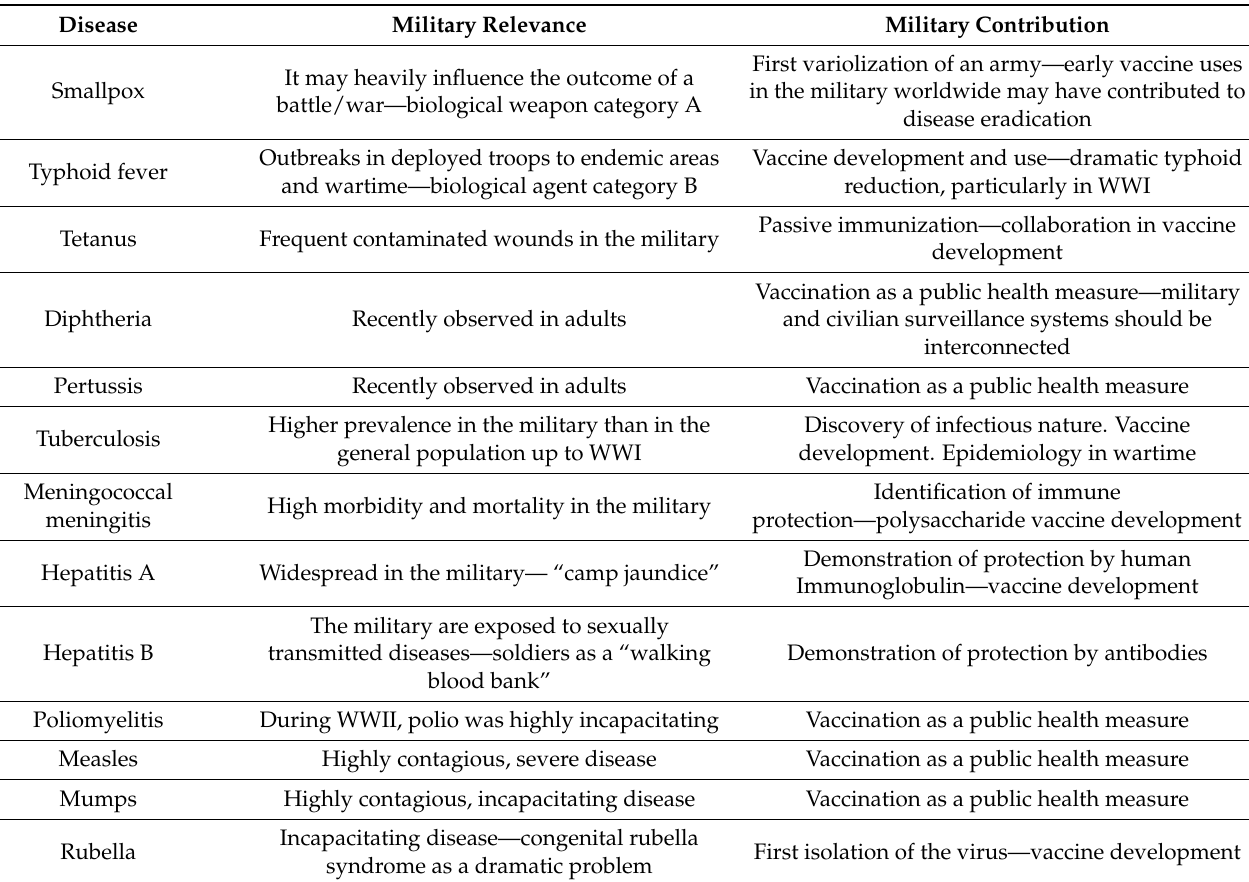
Table 7. Relevance for the military of vaccine-preventable infectious diseases and military contribu- tion to their